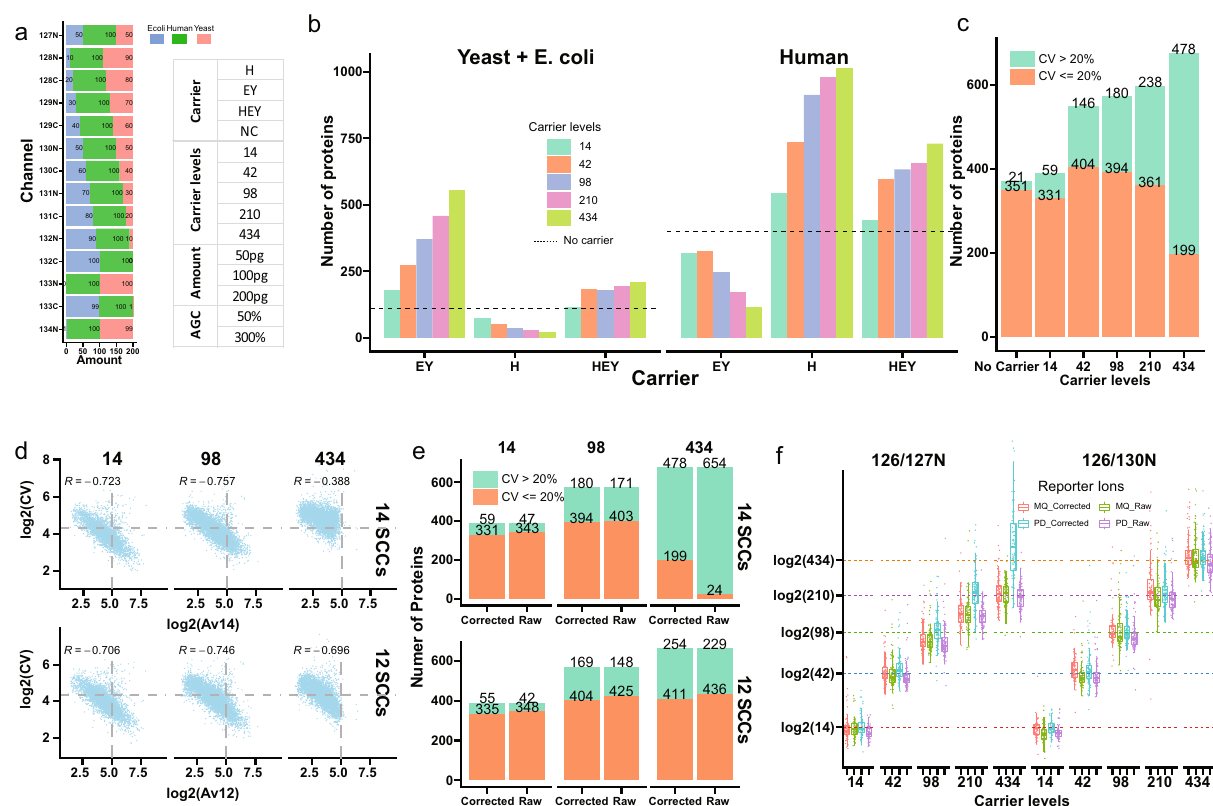
Fig. 1 Explore the carrier effect with TMTpro in mixed-species samples. a Depiction of TMTpro-labeled mixed-species samples and mass spectrometry acquisition settings. Digested peptide mixtures from yeast, E.coli and human HeLa cells were labeled with TMTpro in 14 SCCs and mixed in different proportions. b Number of identi fi ed proteins from different organisms. Samples with the following settings were selected: no carrier and carrier proteome as HEY, H, and EY; AGC300%; 50 pg per SCC; replicate 2. c Number of identi fi ed proteins with different carrier channel ratios. Samples with the